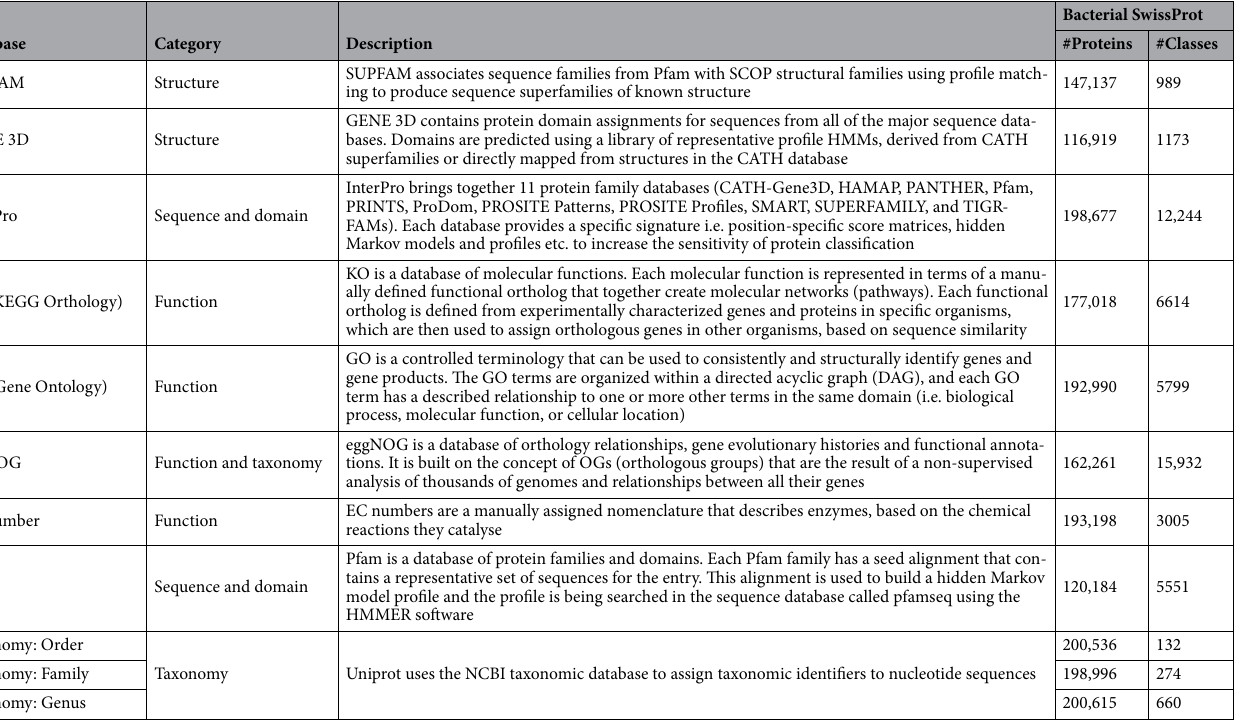
Table 2. Description of Bacterial SwissProt ontology databases. For the label recovery task, we used a number of ontologies that can be assigned to a protein. These ontologies are based on 3D protein structure (SUPFAM, Gene 3D), domains (Pfam, InterPro), function (GO, KO, EC numbers) or provide information about organism of origin